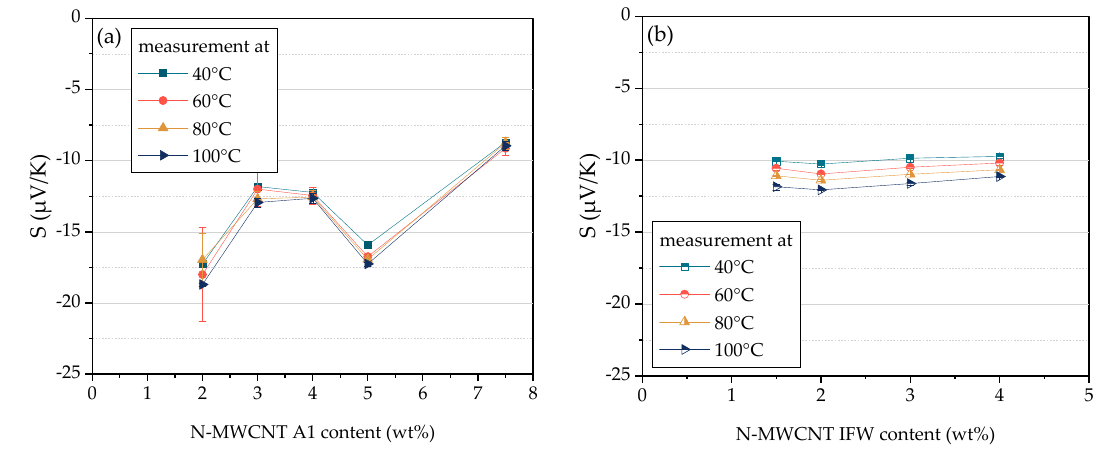
Figure 4. Seebeck coefficient of ( a ) PP/N-MWCNT A1 and ( b ) PP/N-MWCNT IFW composites at different nanotube contents measured at different temperatures.